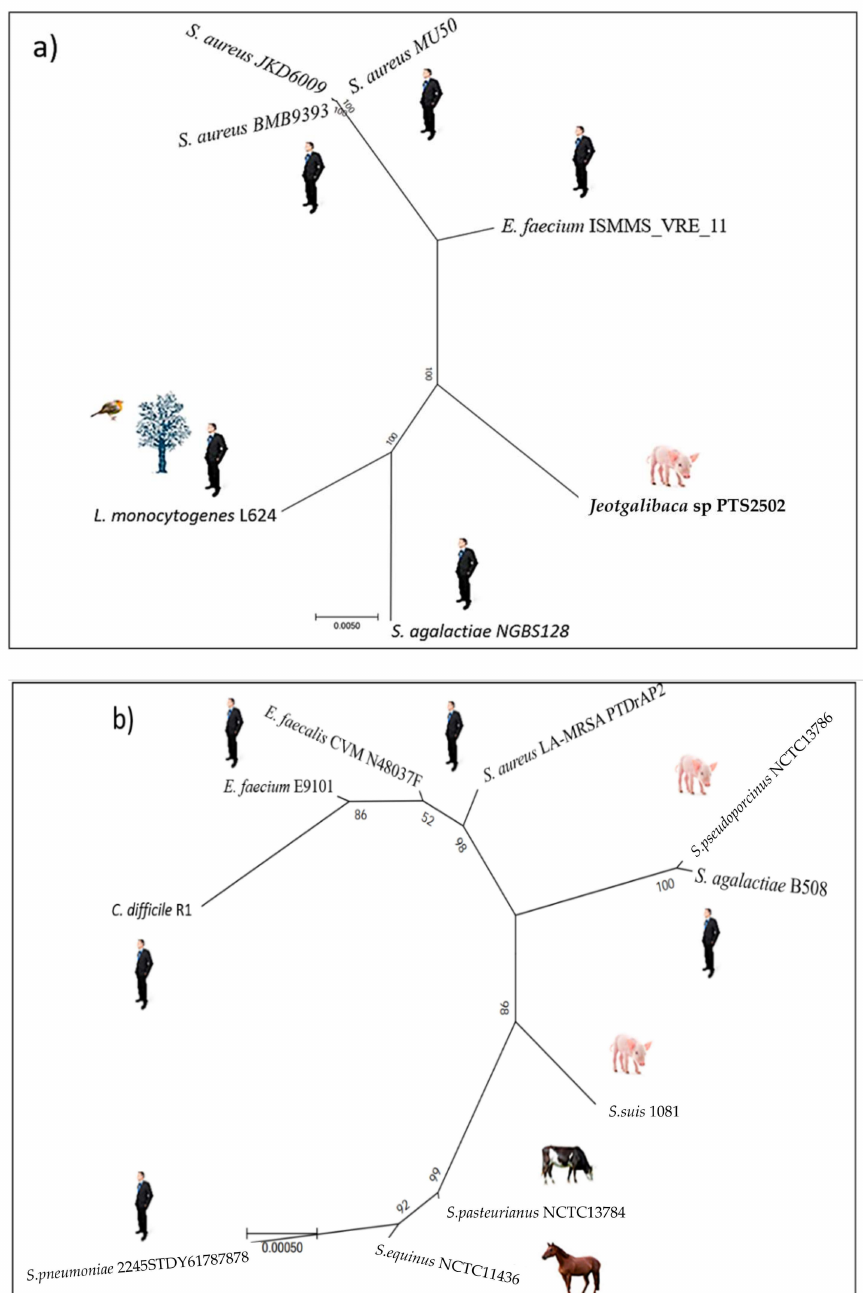
Figure 1. Maximum likelihood tree for ardA homologs of selected Gram-positive species illustrating the distribution of ardA alleles amongst Gram-positive bacteria. ( a ) ardA -H1 homologs. ( b ) ardA -H2